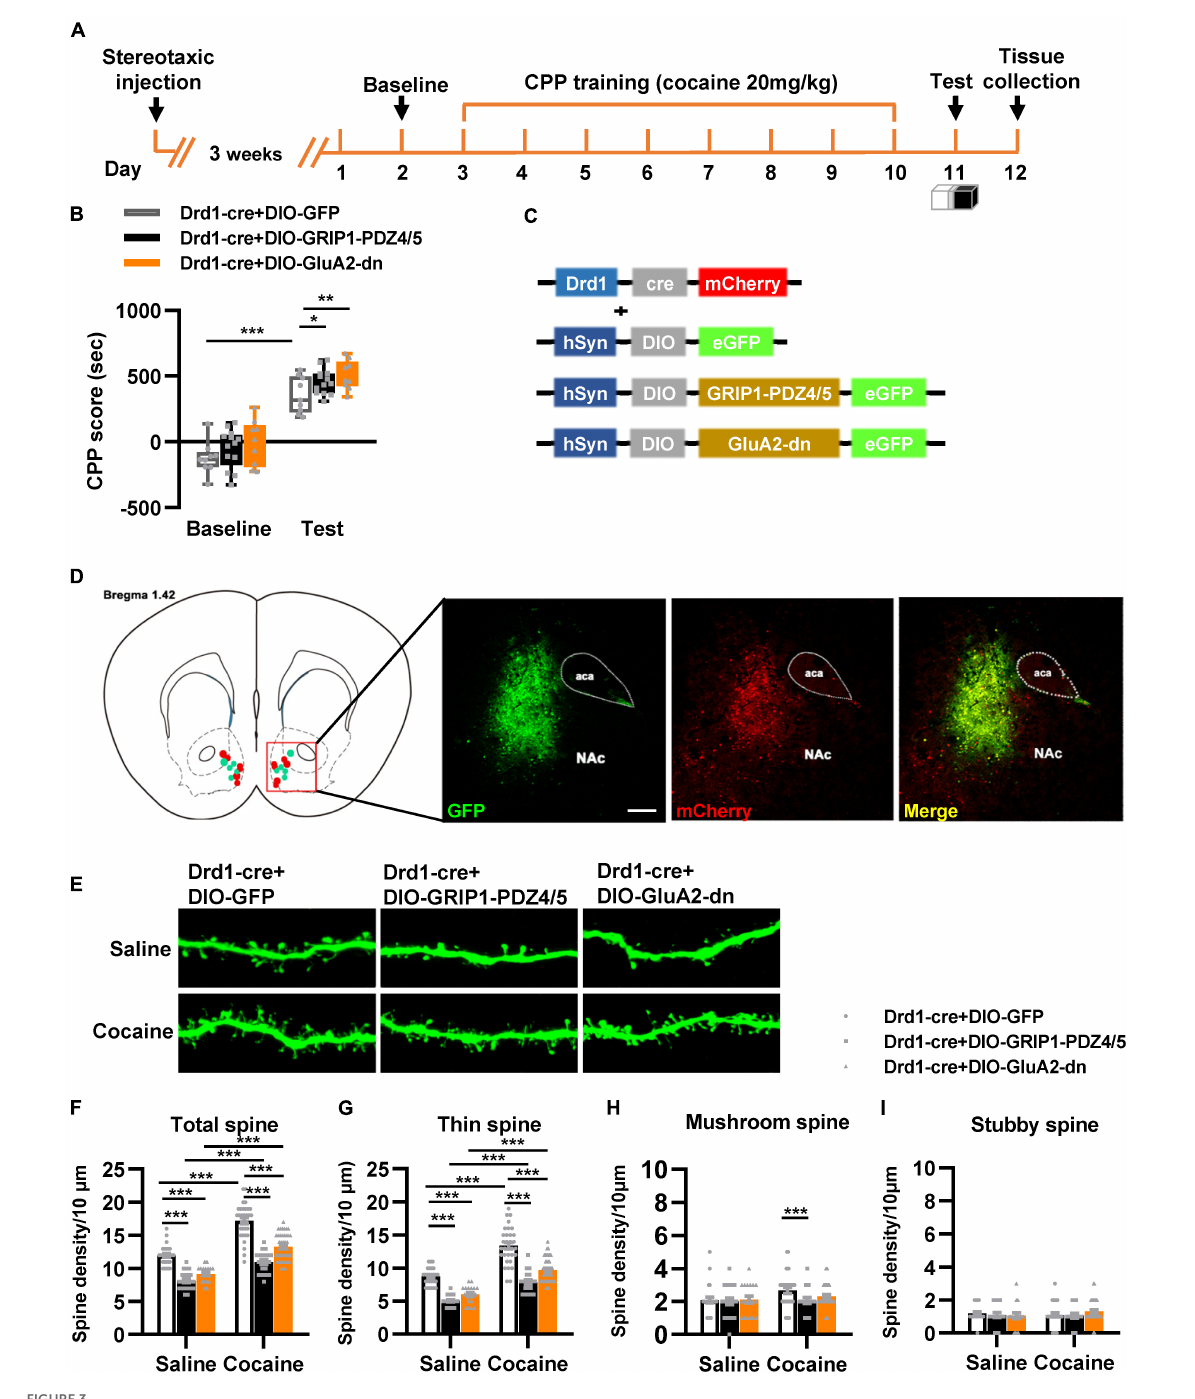
FIGURE3 Interference with GRIP1 and GluA2 interaction in D1-MSNs enhances cocaine acquisition and decreases spine density of D1-MSNs. (A) Experimental design for the behavioral tests and spine analysis. Three-compartment biased CPP models were used. (B) GluA2-dn expressed in D1-MSNs increased cocaine-induced place preference; GRIP1-PDZ4/5 expressed in D1-MSNs did not affect cocaine-induced place preference. (C) Viral vectors used to interfere with the interaction of GRIP1 and GluA2 in D1-MSNs. (D) Representative images of the injection site. (E) Representative images of GFP-labeled dendrites. (F–I) The statistical data for total spine, thin spine, mushroom spine, and stubby spine density. n = 20–30 dendrites obtained from 8–10 mice per group. * P < 0.05, ** P < 0.01, and *** P <